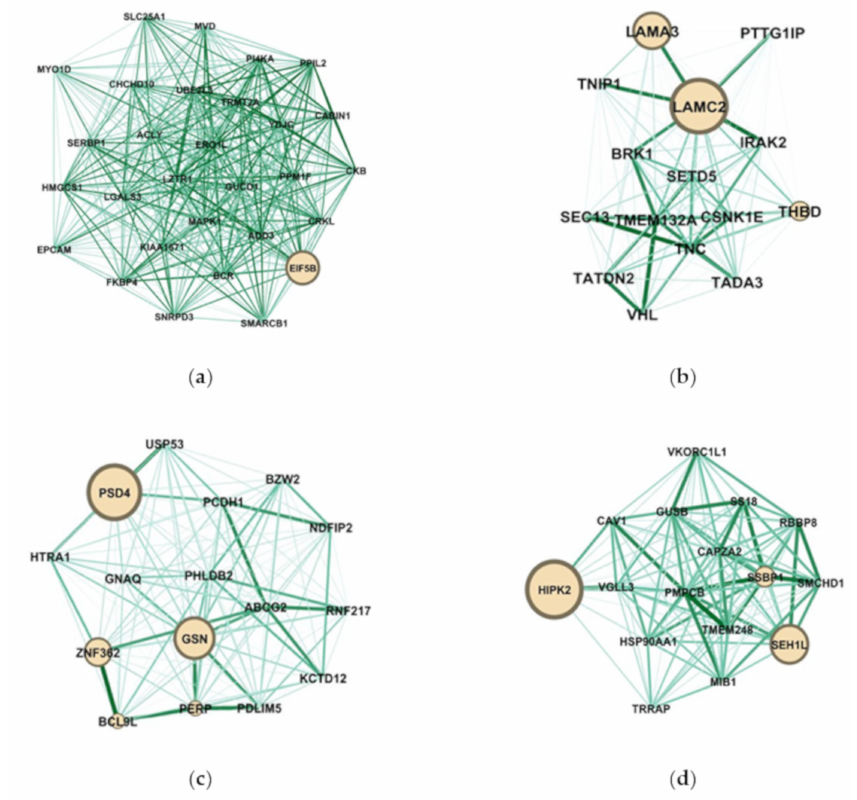
Figure 9. The network of hub genes in the red module, darkturquioise module, lightgreen module, and royalblue module. Nodes represent genes and node size indicates the betweenness score. Edges are colored by weight. ( a ) The network hub genes of human adenocarcinoma lymph node metastasis; ( b ) The network hub genes of grade 2 carcinoma; ( c ) The network hub genes of grade 3; ( d ) The network hub genes of transitional cell carcinoma lymphatic